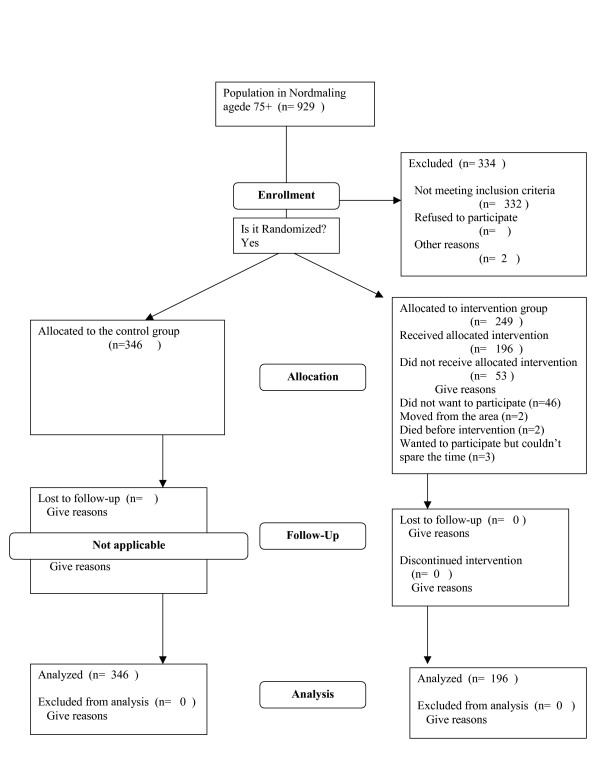
The Consort E-Flowchart.